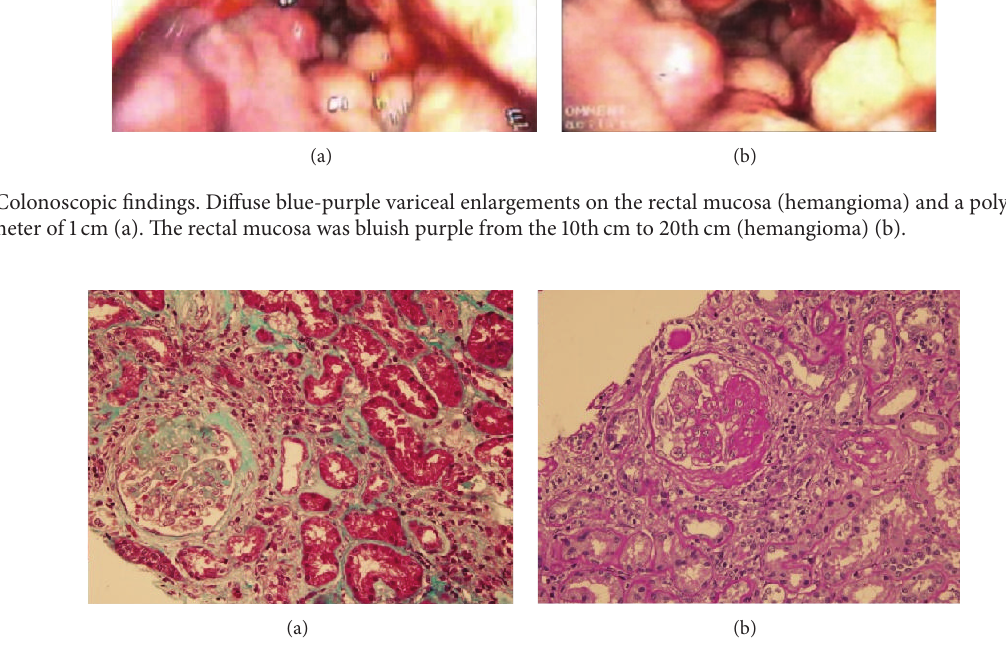
Figure 3: Segmental sclerotic lesion in the glomerulus. (a) Masson trichrome. (b) Periodic acid Schiff